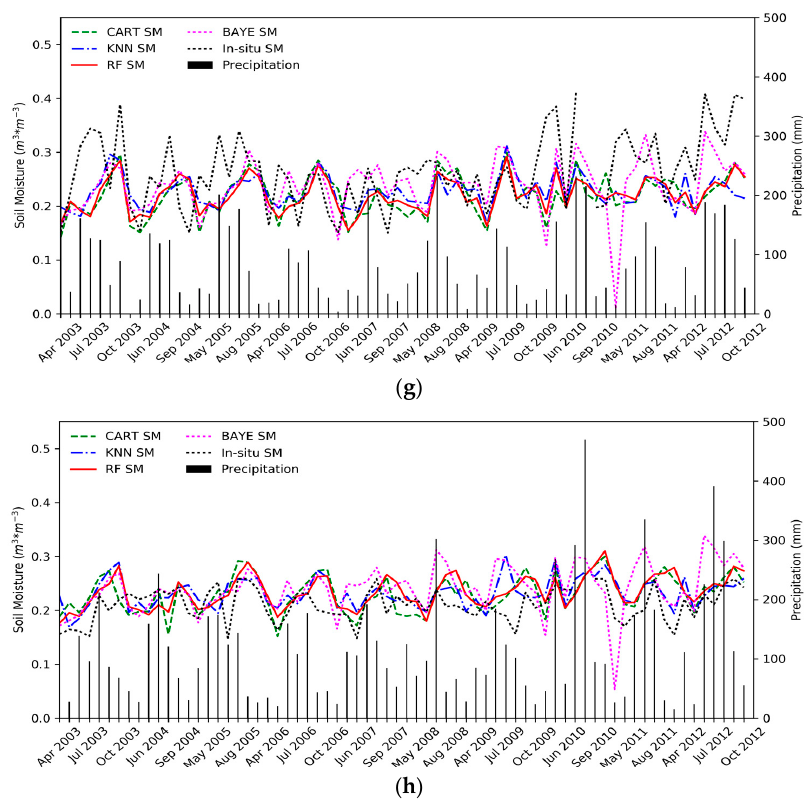
Figure 10. Comparison of the four machine learning downscaled SM, in-situ measurements and precipitation from 2003 to 2012 in unfrozen seasons. ( a − h ) stand for the comparison in in-situ 1, 2, 3, 4, 5, 6, 7, 8 respectively.